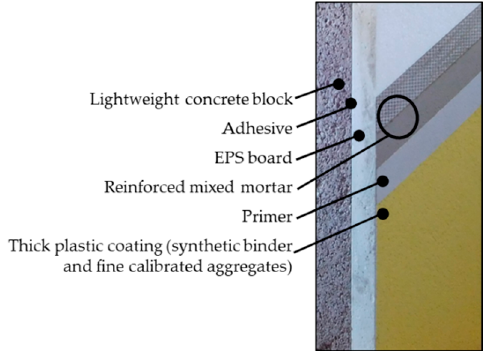
Figure 1. Cross-section of an external wall with External Thermal Insulation Composite System (ETICS) with expanded polystyrene (EPS) applied as external rendering and insulation.